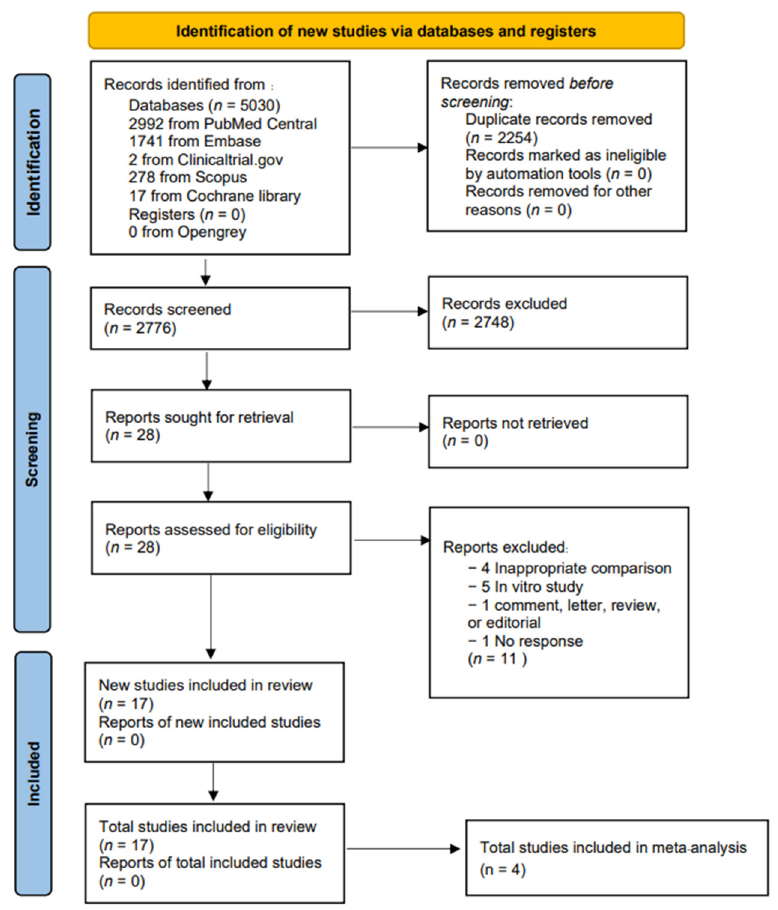
Figure 1. Preferred Reporting Items for Systematic Reviews and Meta-Analyses (PRISMA) flow diagram; summarizes the study selection process.